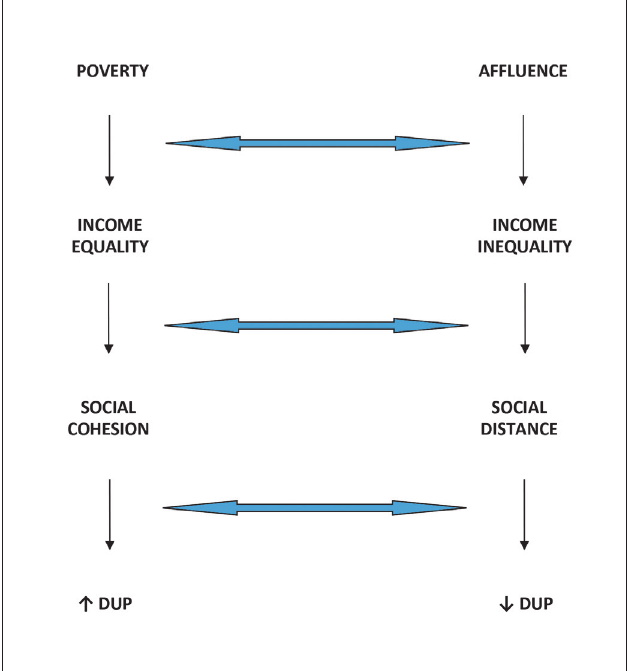
Fig. 2. The effects of poverty, income equality and social cohesion v. affluence, income inequality and social distance on the pathway to care in